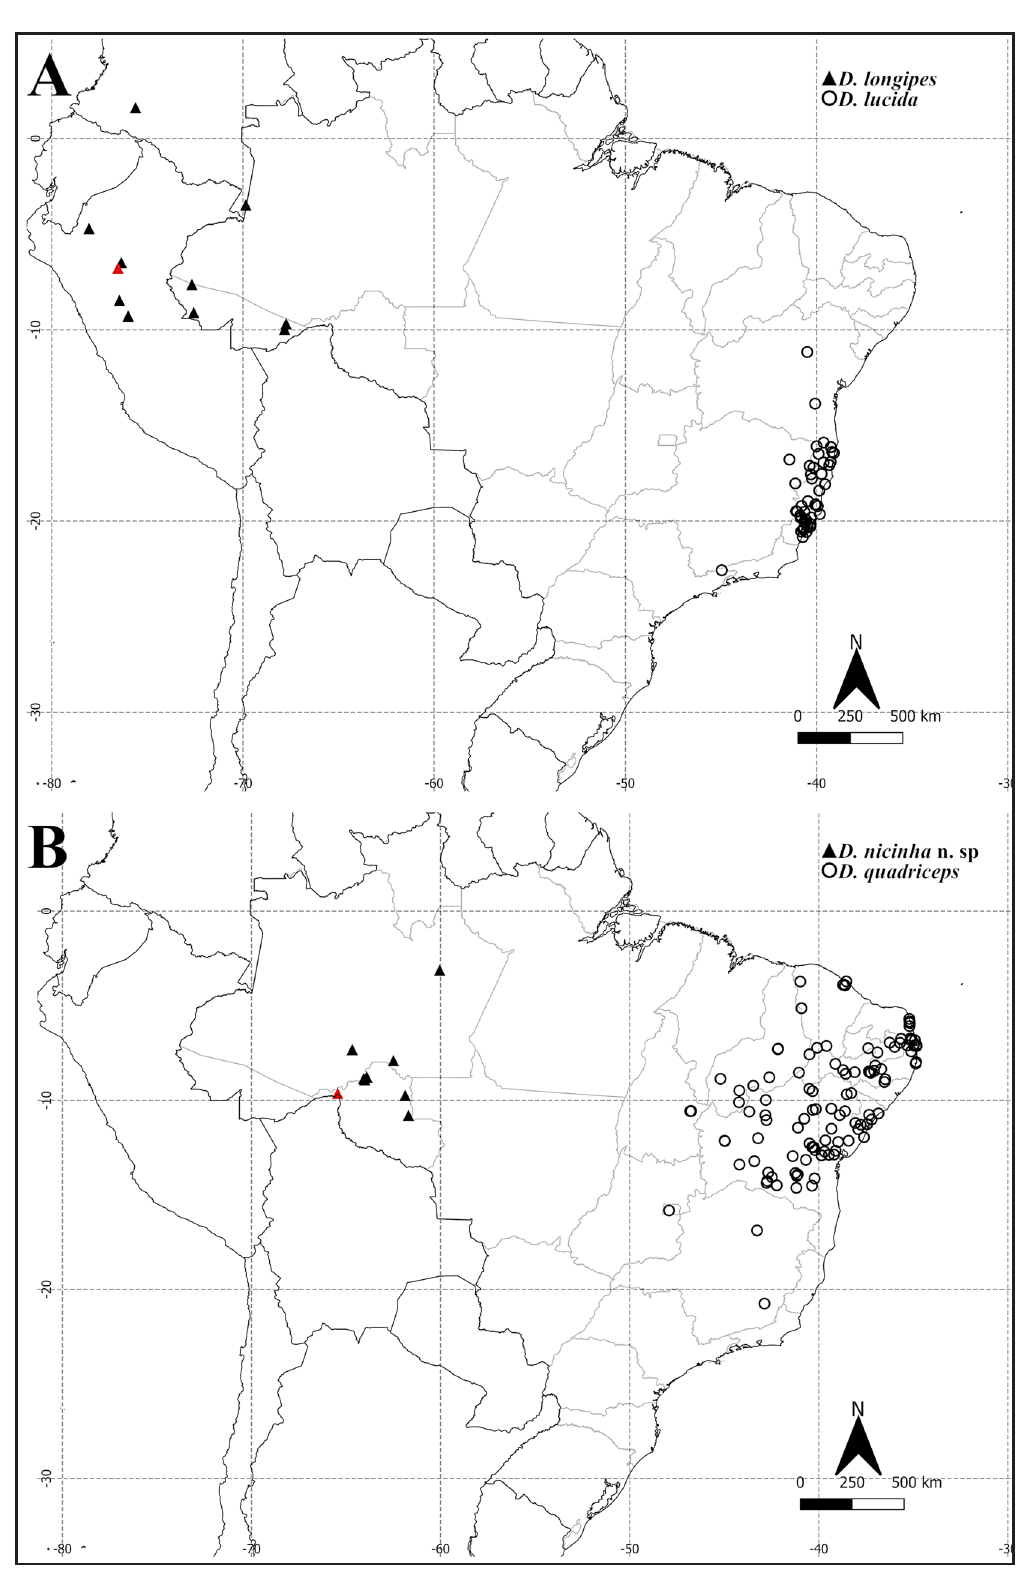
Fig. 29. Distribution maps for species of Dinoponera Roger, 1861. Red symbols indicate type specimens examined here. A . D. longipes Emery, 1901 and D. lucida Emery, 1901. B . D. nicinha sp. nov. and D. quadriceps Kempf,